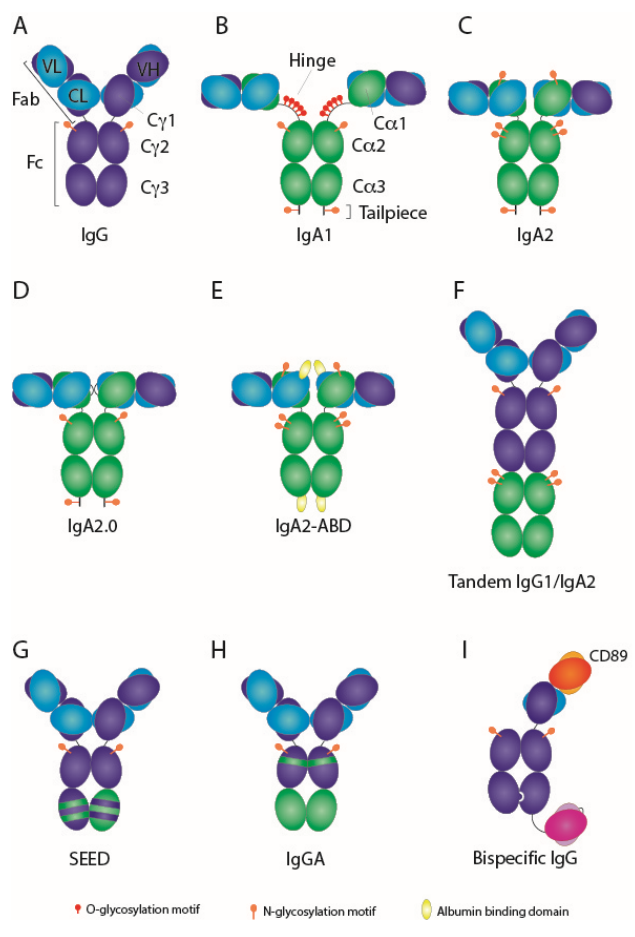
Figure 1. Schematic overview of IgG and IgA formats. ( A ) IgG1 is depicted, with heavy chain in dark blue and light chain in light blue. The variable domains of IgG have been grafted onto IgA creating ( B ) a chimeric IgA1, with heavy chain in green, or ( C ) chimeric IgA2m (1). ( D ) Engineering IgA2m (1) to improve stability and homogeneity resulted in IgA2.0 [26]. ( E ) Albumin-binding domain (ABD) in yellow fused to IgA2m (1) [27]. Illustration of hybrid IgG-IgA molecules: ( F ) Tandem IgG1-IgA [52], ( G ) strand-exchange engineered domain (SEED)-bodies [53], and ( H ) Cross-isotype IgGA [54]. ( I ) FcαRI-engaging (red/orange) × CD20 (pink/purple) bispecific antibody [55].